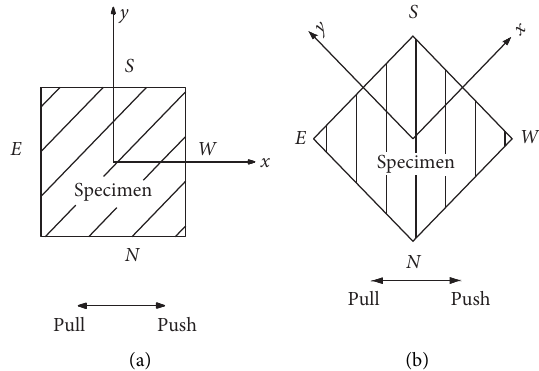
Figure 5: Definition of specimen observation surface. (a) Spindle loading; (b) 45 °